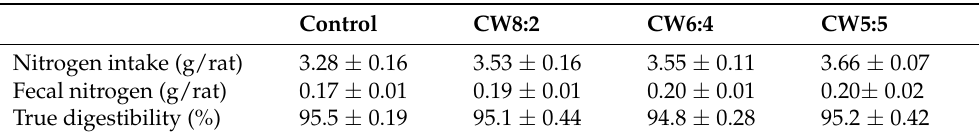
Table 2. Effect of adjusted casein and whey proteins ratio on protein digestibility in rats administered milk with adjusted casein to whey proteins ratios for eight weeks ( n = 6).